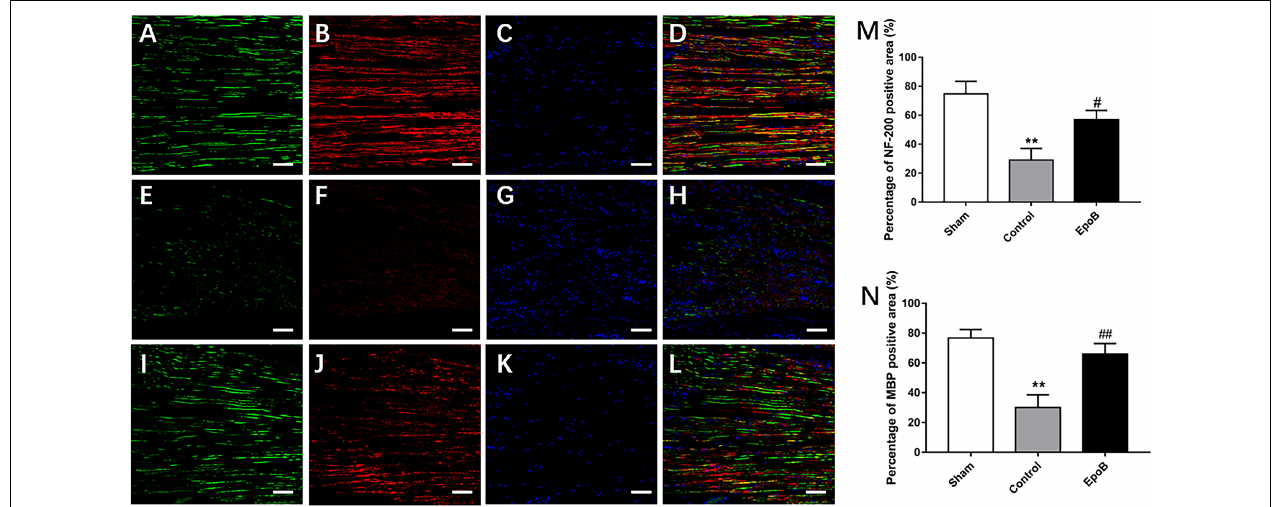
FIGURE 2 | EpoB promotes regeneration of myelinated nerve fibers. Representative regenerated axon images in the nerves stained for NF-200 (green), MBP (red), and DAPI (blue) in the sham (A–D) , control (E–H) and EpoB (I–L) groups at 4 weeks after injury. Treatment of EpoB increased the ratio of positive area of NF-200 (M) and MBP (N) . Scale bars: (A–L) 20 µ m. ** P < 0.01 vs. the sham group; # P < 0.05, ## P < 0.01 vs. the control group. Abbreviations: EpoB, epothilone B; MBP, myelin basic protein; DAPI, 4,6-diamidino-2-phenylindole.